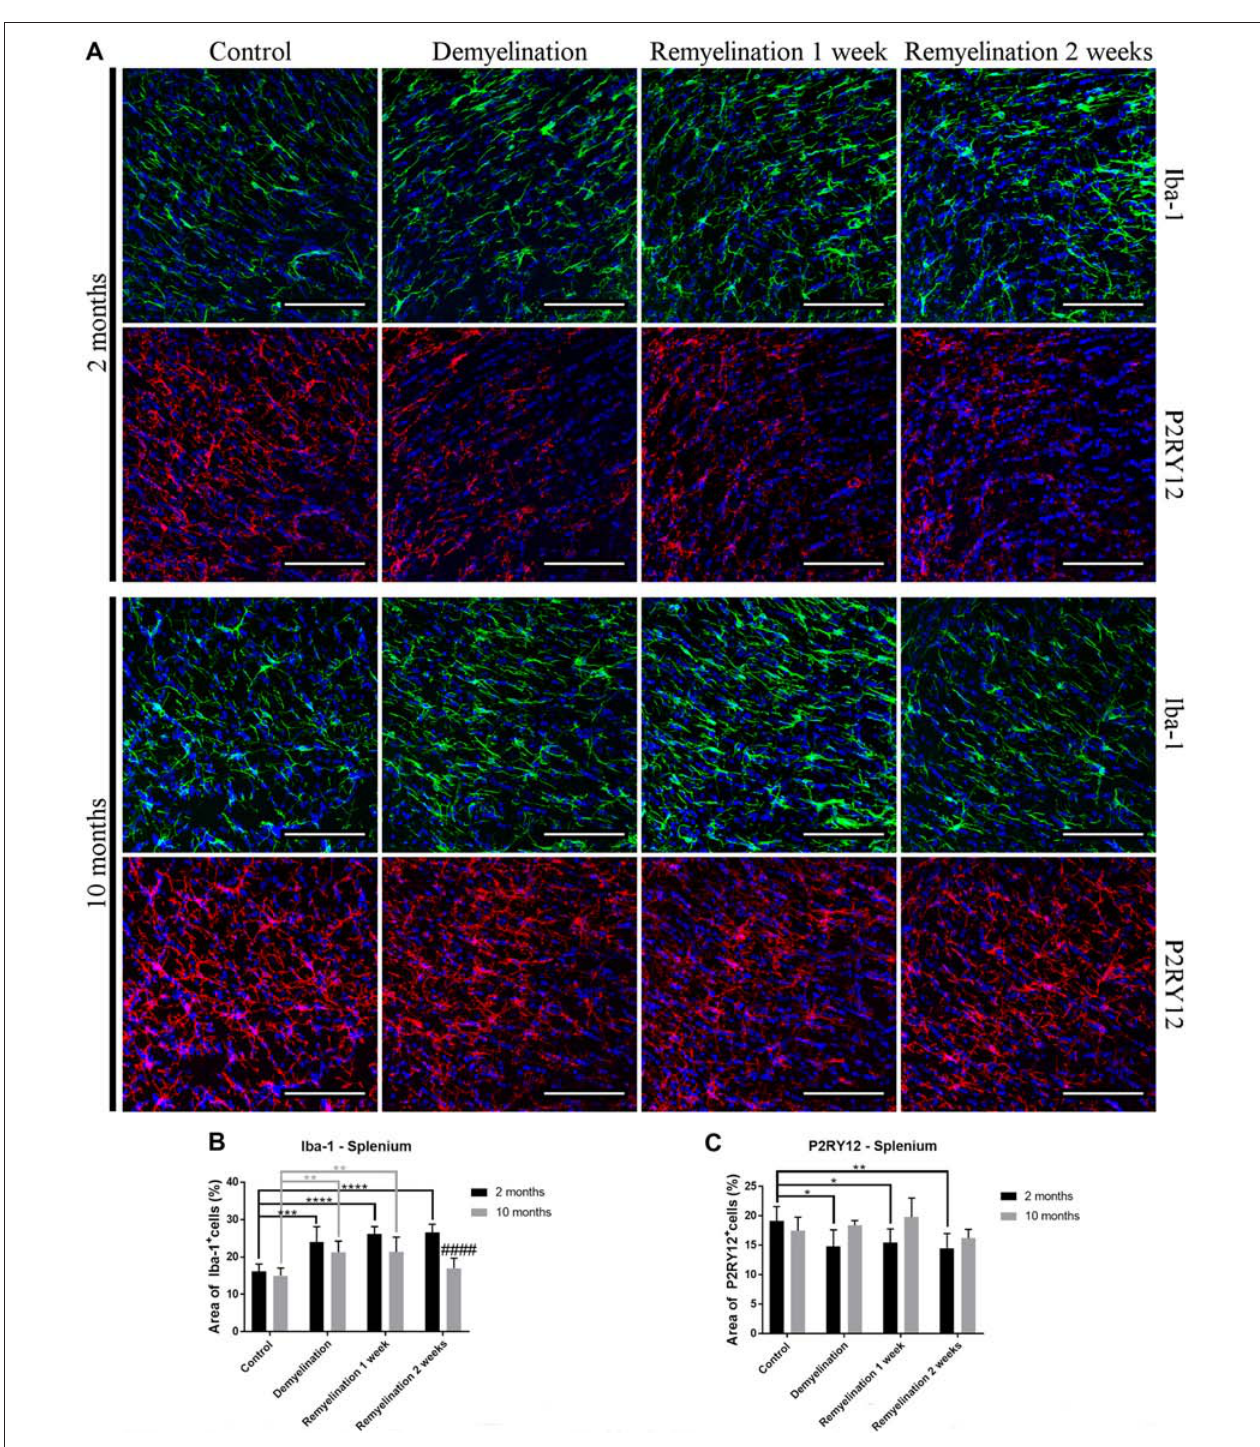
FIGURE 3 | Age- and region-dependent differences in Iba-1 and P2RY12 during de- and remyelination in the splenium of the CC. (A) Iba-1 (green) and P2RY12 (red) labeling. Cell nuclei are stained with DAPI (blue). (B) In young mice, Iba-1 was up-regulated during all phases of de- and remyelination, while in the middle-aged group Iba-1 returned to control levels after 2 weeks of remyelination, resulting in an age-related difference at this time point. (C) A significant reduction of P2RY12 in the splenium was observed only in the younger group during de- and remyelination. In the middle-aged group P2RY12 levels were not changed during de- or remyelination. Values are shown as means + SD ( n = 6 per group). Statistical significance was evaluated using a two-way ANOVA and a Tukey’s post hoc test. The p -values are indicated in the graphs: treatment effects within the same age group: ∗ p < 0.05, ∗∗ p < 0.01, ∗∗∗ p < 0.001 and ∗∗∗∗ p < 0.0001, age-related differences: #### p < 0.0001. Bars: (A) 100 µ